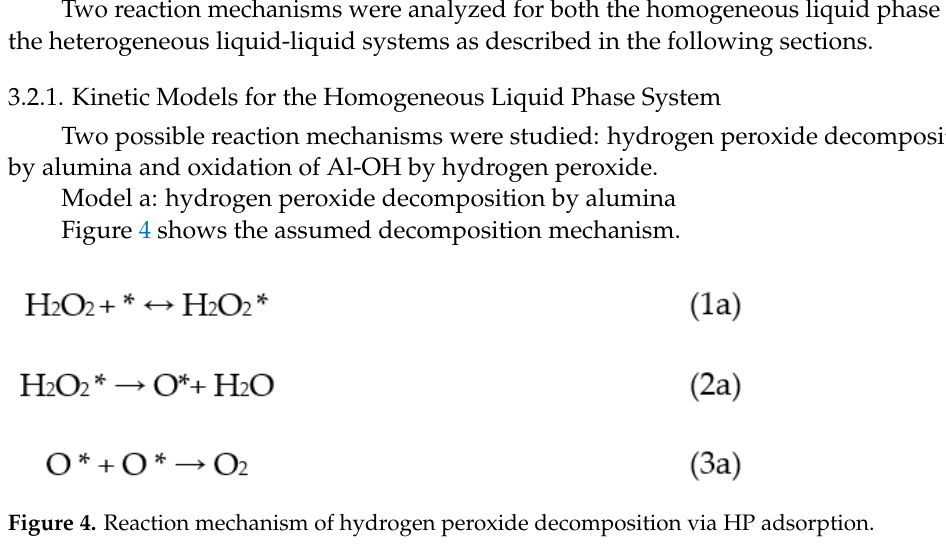
Figure 3. Evolution of the equilibrium ratio for hydrogen peroxide at different temperatures: ( A ) ratio 1-1; ( B ): ratio 1-2; ( C ): ratio 2-1. Table 3. Liquid-liquid ratio and calculated values of K HP .